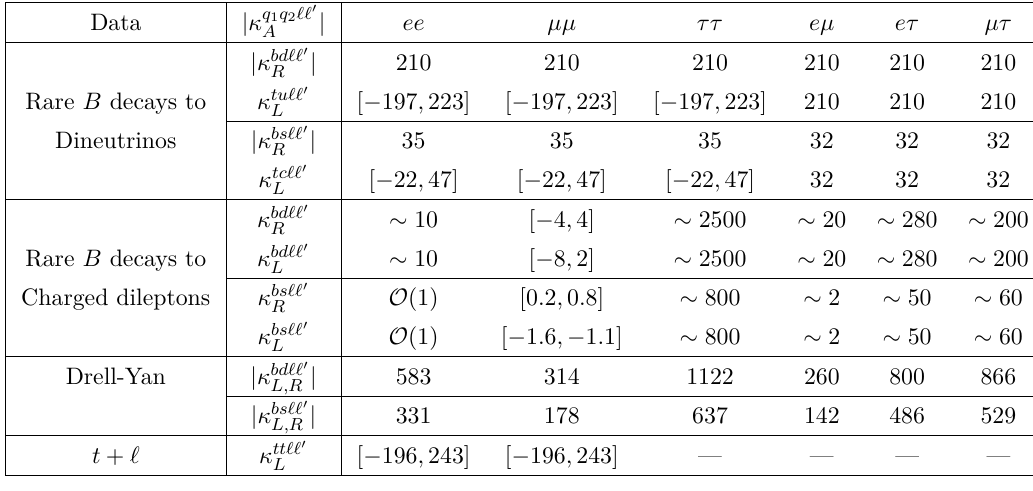
. The first row A